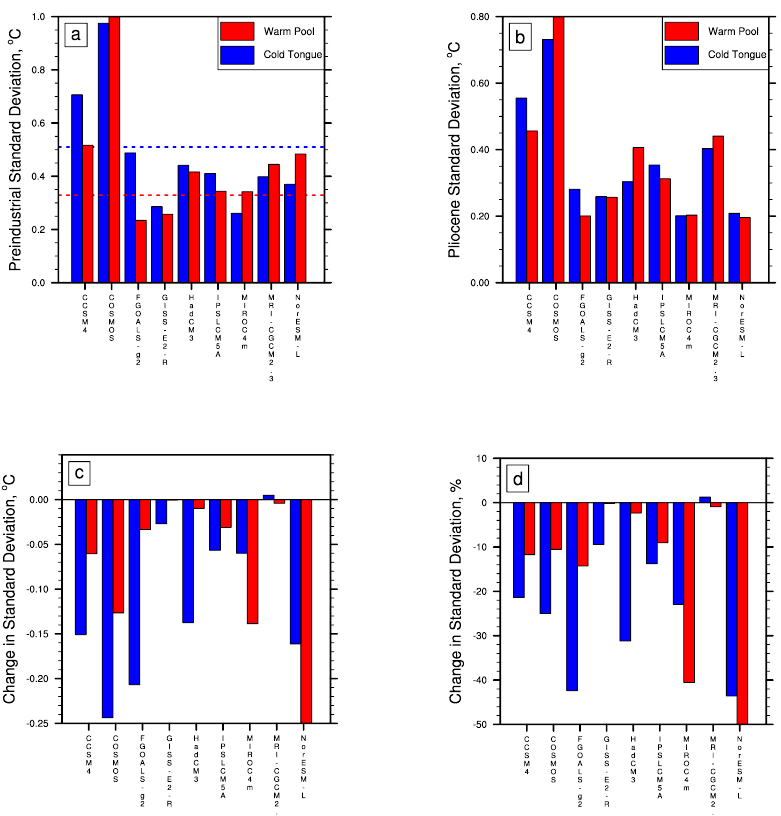
Figure 4. Response of the two different flavours of ENSO considered separately. The flavours are disaggregated using the method of Ren and Jin (2011) into cold-tongue and warm-pool types. The red and blue dashed lines indicated the standard deviation found in the ERSST observations.